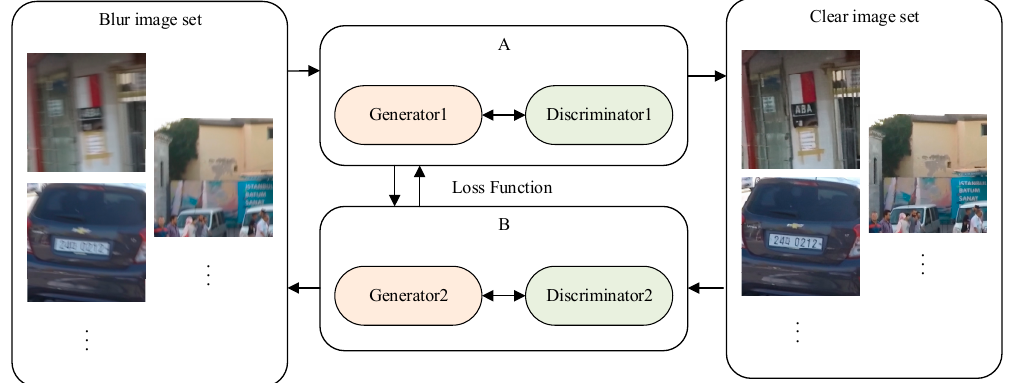
Figure 1. The overall structure of the model.